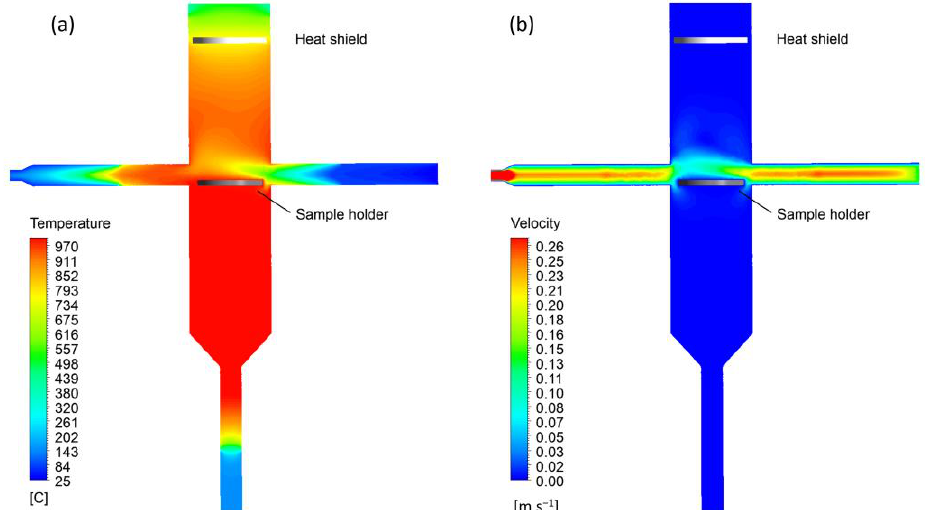
Figure 5. The results from the CFD simulations of the TGA when operated at a constant temperature of 1000 °C in air: ( a ) temperature profile and ( b ) velocity profile. The positions of the sample holder and a heat shield are indicated in the figure. The 11 mm wide sample holder can be used as a reference for the